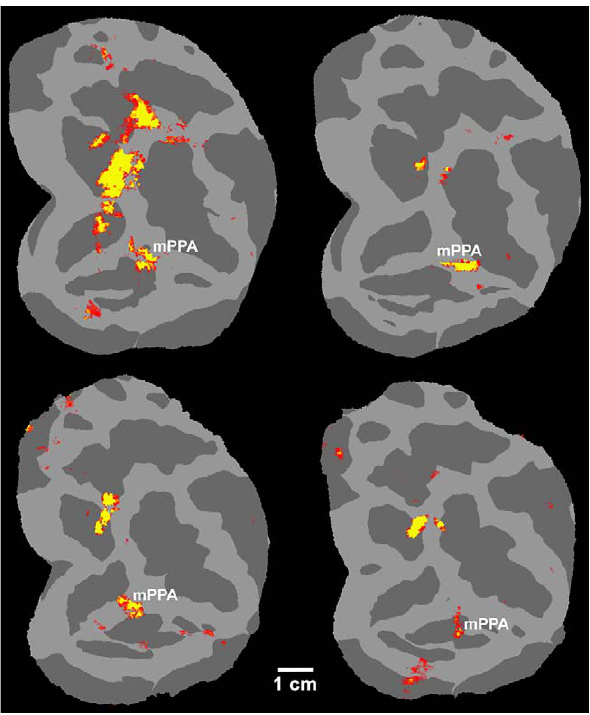
Figure 8. Evidence for a monkey homolog of PPA in individual maps. The maps show the activity produced by place images, in a comparison of places versus faces (map threshold: p , 10 2 4 ), in awake monkeys. The activity map is displayed on a flattened view of macaque visual cortex in two monkeys (four hemispheres). The left panels show right hemispheres. The right panels show left hemispheres, mirror- reversed for ease of comparison. In all hemispheres, a place-selective patch (mPPA) was consistently localized in posterior IT cortex, adjacent/ overlapping the posterior middle temporal sulcus, immediately ventral to the posterior temporal face patch (not shown). The topographic location of mPPA was slightly variable across individuals. A similar individual variability has been reported for the location of peak activity in human PPA ([49] and unpublished data). An additional place- selective patch was also localized in the anterior bank of the lunate sulcus, in occipito-parietal cortex. Presumably this dorsal patch is the monkey homolog of an additional human place-selective area located in the transverse occipital sulcus.